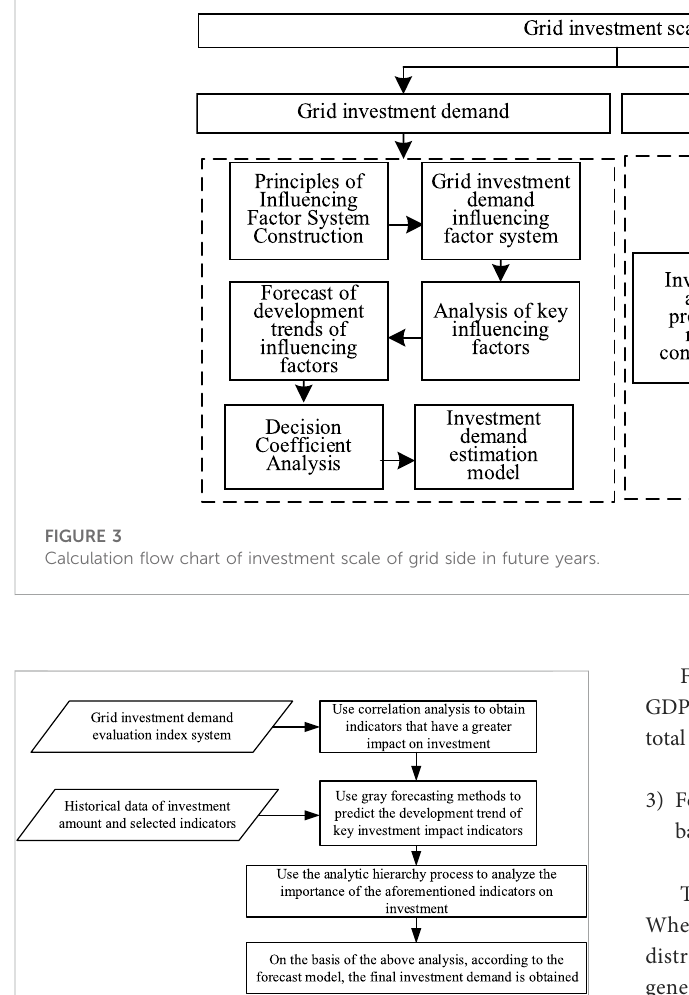
FIGURE 4 Investment demand forecasting